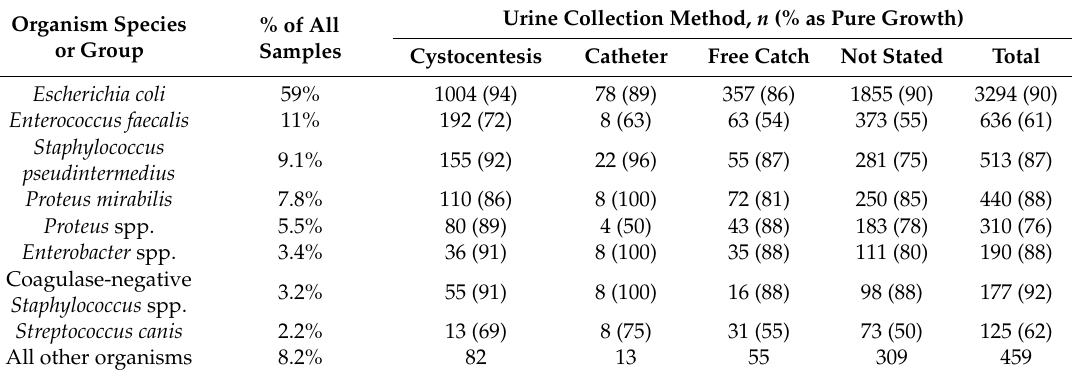
Table 1. Organisms cultured for each collection method and proportion cultured as a pure